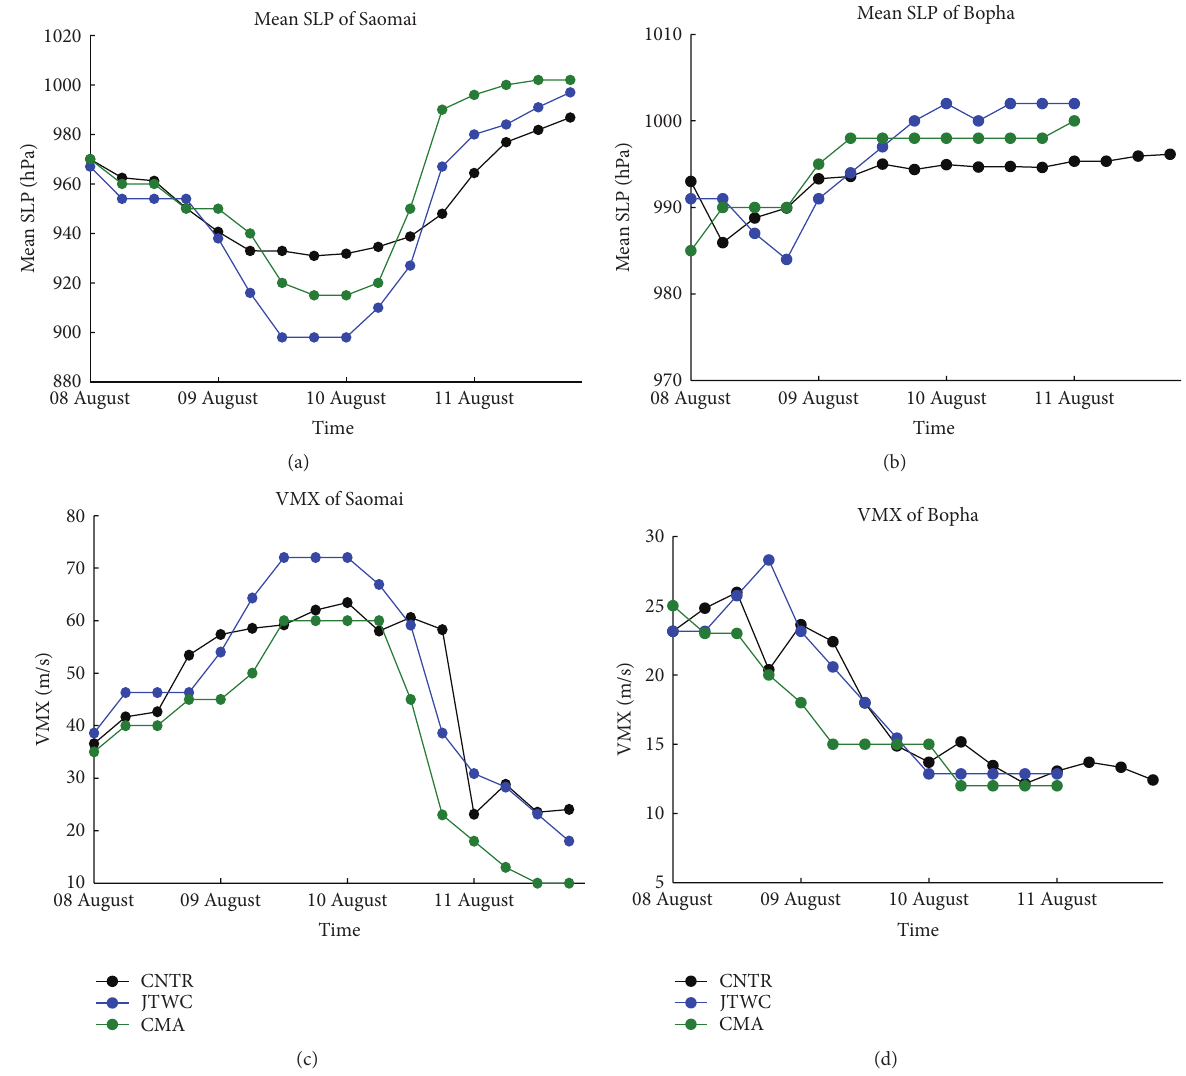
Figure 3: The 6-hourly minimum sea-level pressure (hPa) of best tracks of CMA and JTWC and simulated tracks of CNTR of Saomai (a) and Bopha (b) from 0000 UTC 8 August to 1800 UTC 11 August, 2006. (c) and (d) are corresponding to (a) and (b) except for 10-meter maximum wind.